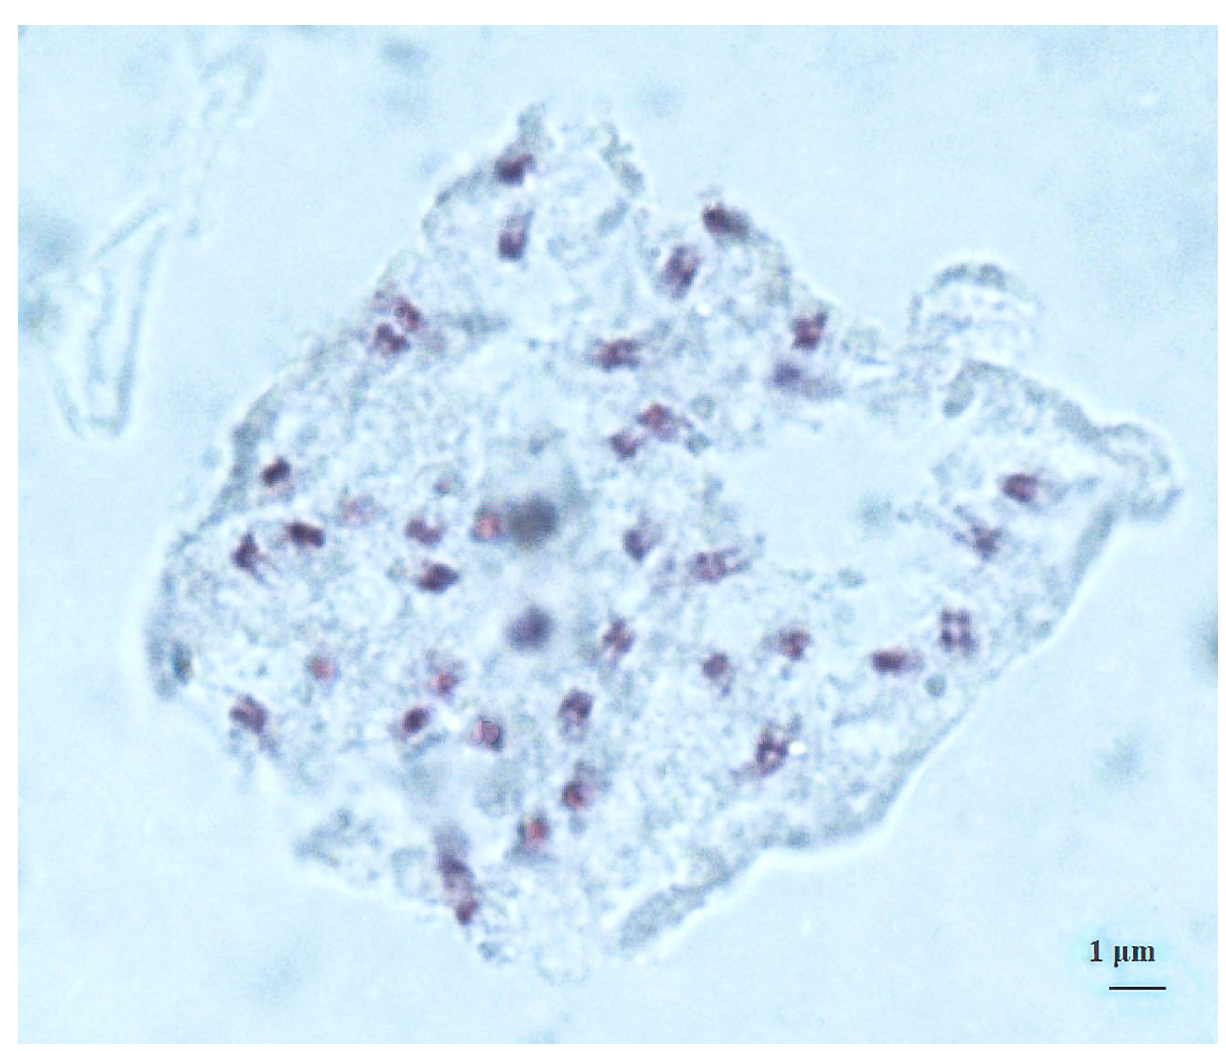
Fig 12. Chromosomes at somatic metaphase (Feulgen staining) of × Pseudorhiza nieschalkii nothosubsp. siculorum hybrid 2n = 40 ( ± 2), no. 28–2 (Fig 12); no. 30–1 (Fig 13); no. 31–4 (Fig 14). Scale bar = 1 μ m.